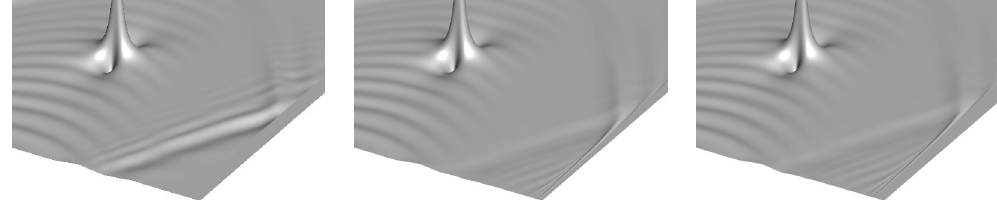
(¯ y ) = 0 . 5[1 tanh(2¯ y )]; δ = 4% (left), δ = 8% 2 −